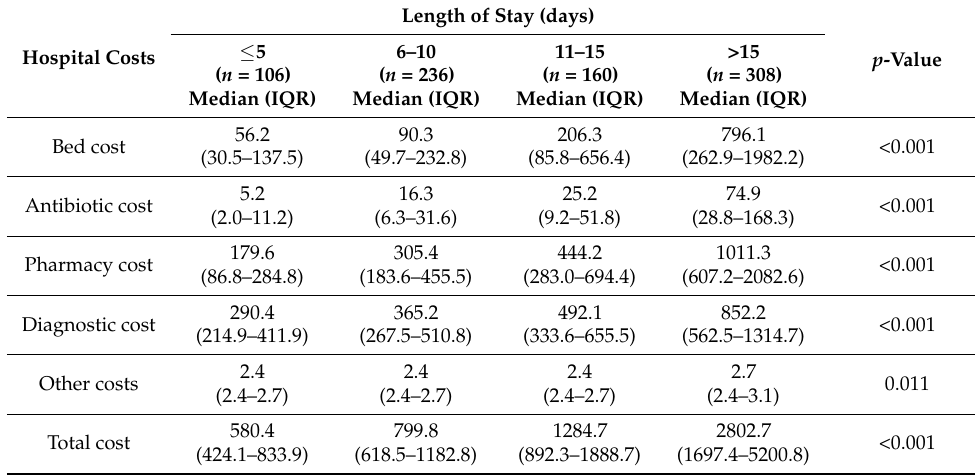
Table 5. Comparison of various costs per patient by the length of stay (in 2021 US$).